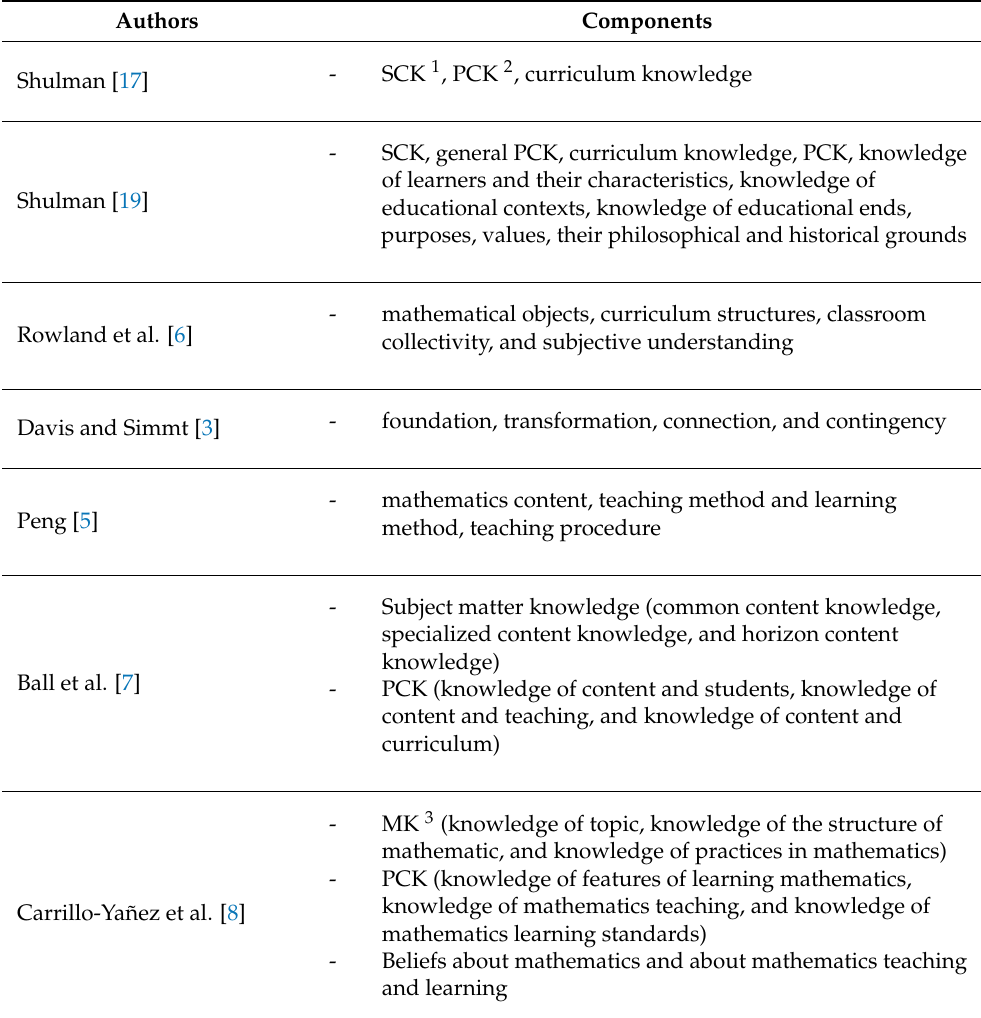
Table 1. Component of mathematics teachers’